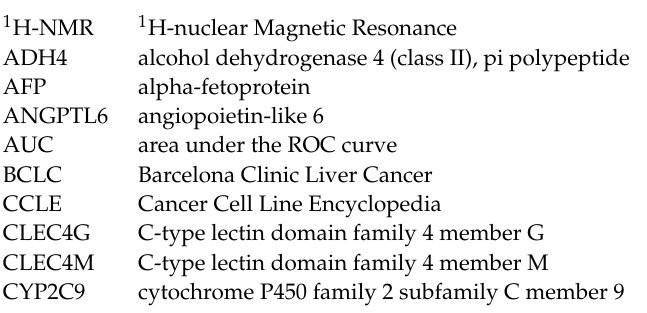
Table S4: Clinical characteristic information of eight HCC patients. Table S5: Methylation analysis of 10 DEGs in LIHC by the cBioPortal platform. Table S6: Correlation analysis of the expression of 10 DEGs with the infiltration level of six immune cell types in HCC. Table S7: Characteristics of early primary HCC patients. Table S8: Characteristics of HCs and early primary HCC patients with normal serum AFP levels. Table S9: Characteristics of early primary HCC patients and CHB patients with normal serum AFP levels. Table S10: Characteristics of early primary HCC patients and the noncancer group with normal serum AFP levels. Table S11: Serum ANGPTL6 Levels for the Diagnosis of Early Primary HCC with normal serum AFP levels. Table S12: Comparison of serum lipoprotein subfraction levels in early-stage HCC patients and HCs. Table S13: Correlation analysis of serum ANGPTL6 and selected lipoprotein subfractions in patients with early-stage